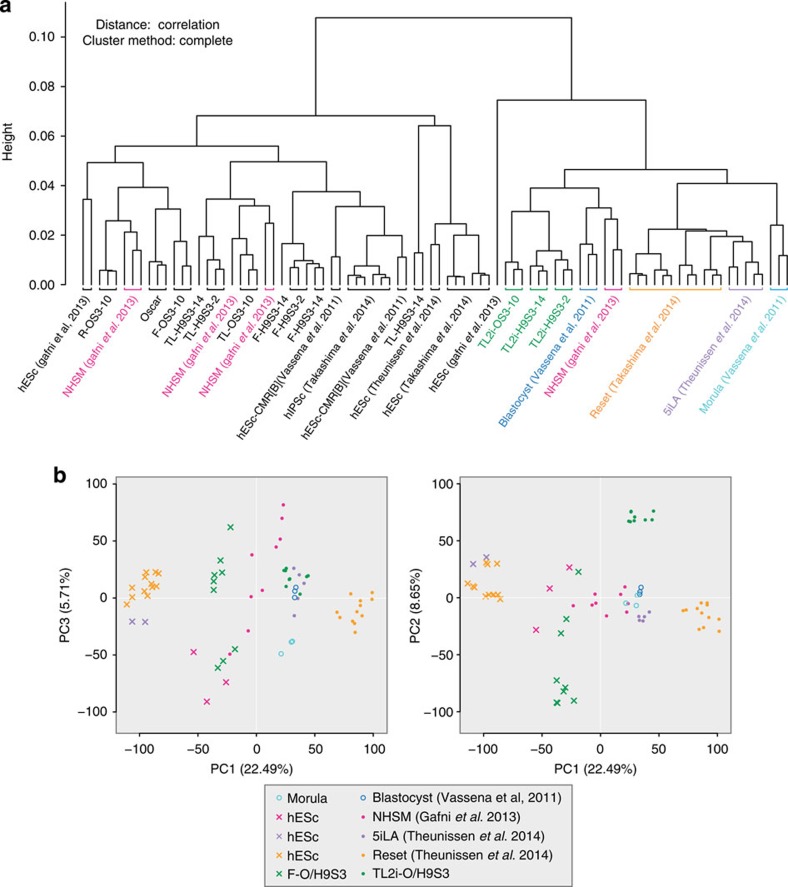
Transcriptome reconfiguration towards human embryo.(a) Correlation clustering of transcriptome data for OSCAR, F-OS3–10, F-H9S3-2, F-H9S3–14, TL-OS3–10, TL-H9S3-2, TL-H9S3–14, TL2i-OS3–10, TL2i-H9S3–2, TL2i-H9S3–14, NHSM hESCs and hiPSCs10, 5i/L/A hESCs14, Reset hESCs15, hESc-CMR[B]47, human morula and blastocyst47. (b) Graphical representation of PCA calculated from the aforementioned compendium. Left panel: axis 1 and 3; right panel axis 1 and 2.